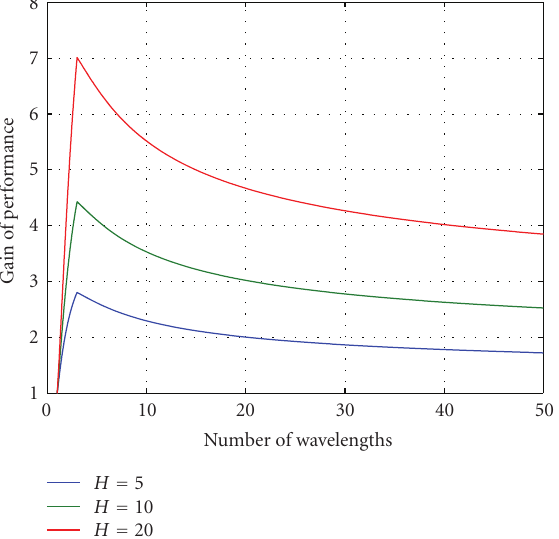
Figure 8: The gain of wavelength conversion G W = f ( W ), P b = 10 − 3 , F = 1, k = 3, and Lim/No.